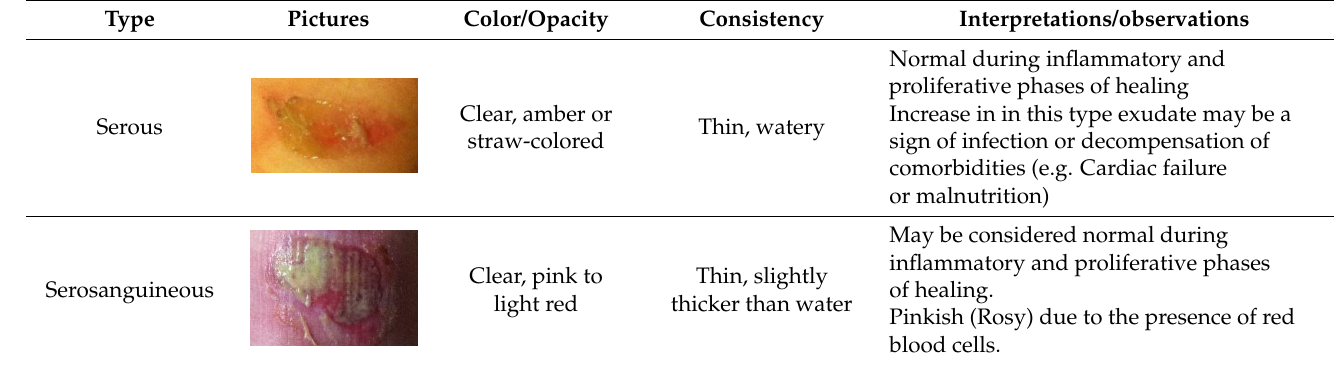
Table 2. Types of wound exudate. Based on [44,55–57].